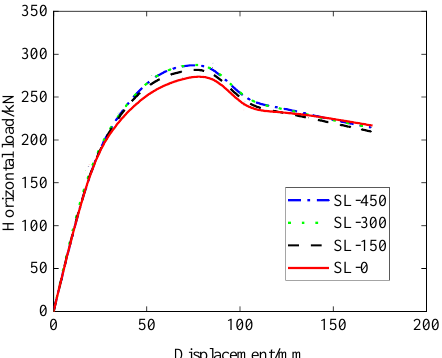
Figure 11. Load – displacement curve (effect of seam location). Figure 11. Load–displacement curve (effect of seam